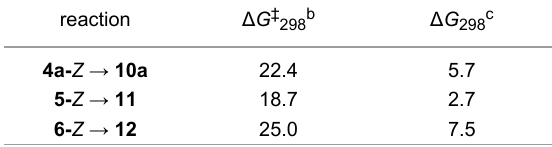
Table 2: Calculated free energy activation and change (kcal/mol) for cyclization of cis -azoazines to the nonaromatic product in MeCN.